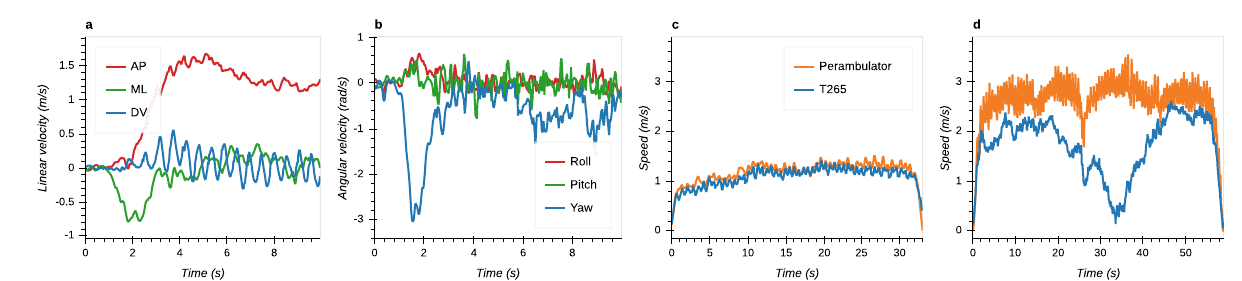
Figure 7. Example time series of velocities measured by T265. ( a ) Linear velocity in AP, ML and DV directions in optical tracking space during walking. ( b ) Angular velocity around roll, pitch and yaw axes in optical tracking space during walking. ( c ) Comparison between speed measured by T265 and perambulator during walking in hallway environment showing successful tracking, see Fig. 3e. ( d ) Comparison between speed measured by T265 and perambulator during running in courtyard environment showing unsuccessful tracking with considerable under-estimation of speed, see Fig. 3.09, p 0.073 , Fig. 5d). Median RYEs (AYEs) are between 3 and 5° and are not dependent on task ( F ( 2, 16 ) = = increased from 0.9 to 1.4°from slow walking to running, although the overall effect is not statistically significant 0.46, p 0.637 , Fig. 5e). YDr depend on task ( F ( 2, 16 ) 6.98, p 0.007 ) and are higher during ( F ( 2, 16 ) = = = = 0.034 , medians between 1 and 3.5°/h, Fig. 5f). running than slow walking ( p = Orientation relative to gravity as tracked by both T265 and OTS shows an elongated distribution around the pitch axis (Fig. 6a and b). The gravity direction errors (GDEs) are relatively small and similar for both pitch 8.49, p 0.003 ). and roll axes (Fig. 6c). Median values are between 1.6 and 3° and depend on task ( F ( 2, 16 ) = = 0.026 ) and running Specifically, they are smaller in the walking task in comparison with the slow walking ( p = 0.014 , Fig. 6d). task ( p = Linear and angular velocity measures were also compared. Example traces from both studies are shown in Fig. 7. 3-DOF linear and angular velocities of a participant measured by the T265 while walking in the optical tracking space are displayed in Fig. 7a,b. Panels c,d compare earth-horizontal movement speed calculated from the T265 data with the gold standard perambulator measurements. Fig. 7c demonstrates a case of successful track- ing in the hallway environment during walking, corresponding to the trajectory shown in Fig. 3e. In contrast,